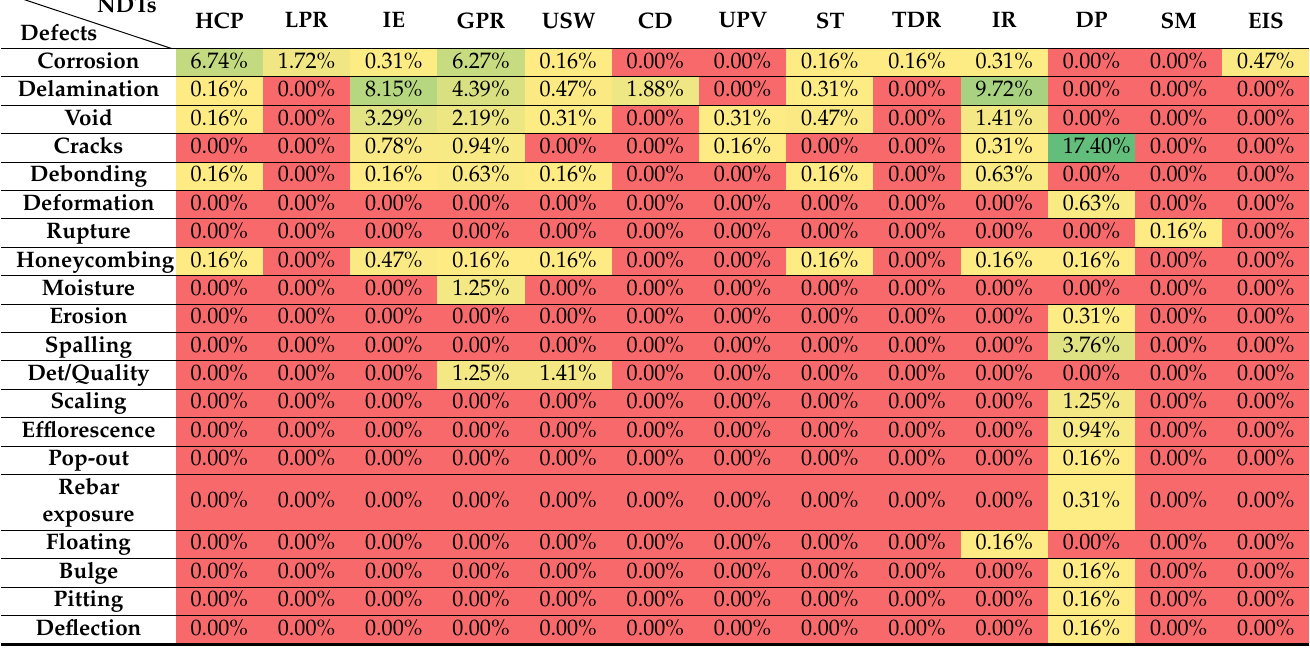
Table 10. Literature review matrix of concrete bridge defects and some used